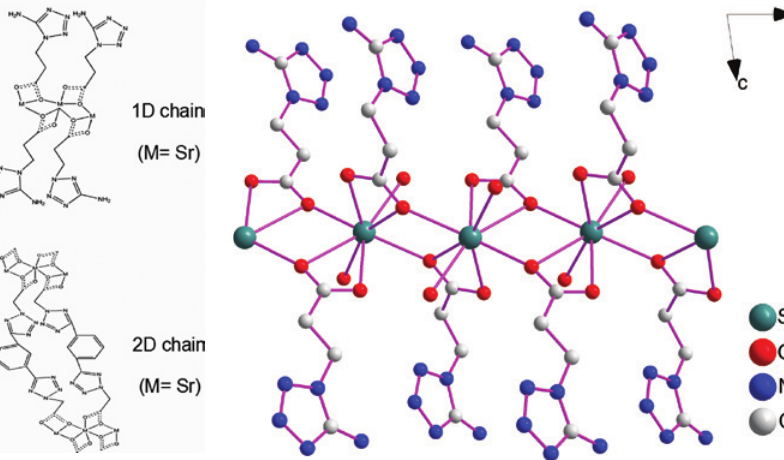
Figure 2: The 1D chain structure of 1 which is extending along the a axis. Hydrogen atoms are omitted for clarity.